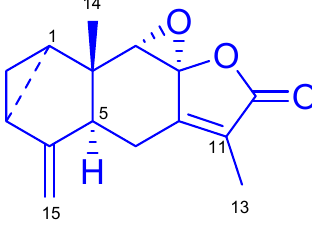
Figure 1. Chemical structure of chloranthalactone B (CTB).